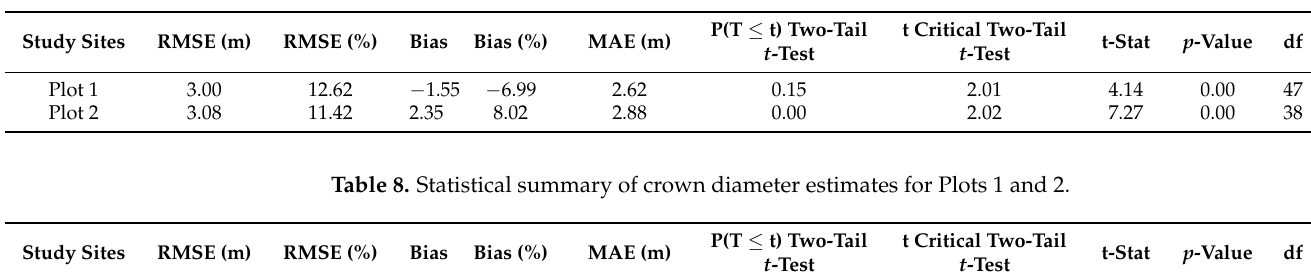
Table 7. Statistics of the measured and estimated crown diameter variables for the two study sites at the tree level.